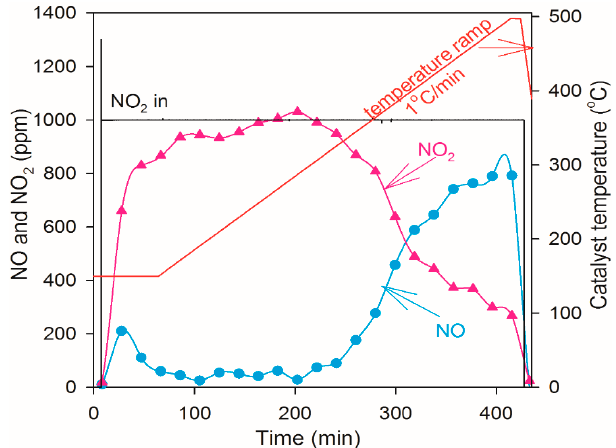
Figure 9. The NO and NO 2 profiles as function of the time during NO 2 dissociation over 2 wt. % Pt/Al 2 O 3 catalyst. Experimental procedures are described in Section 3.